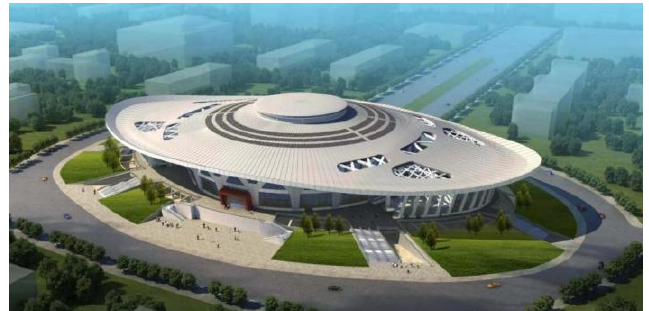
Figure 1. Overall effect drawing of the building.